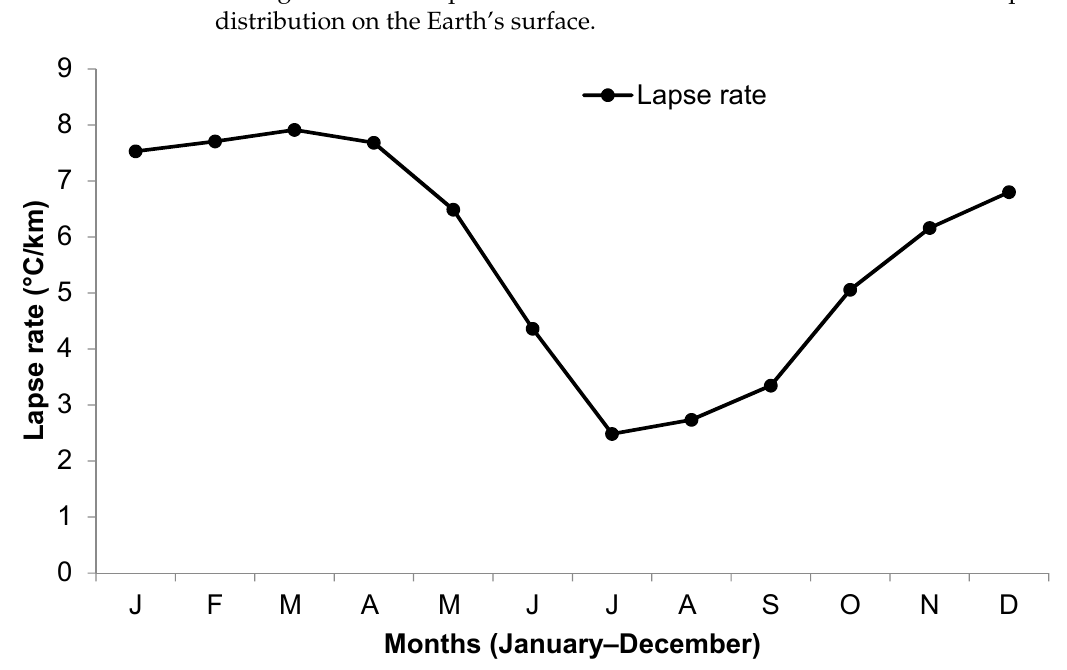
Figure 10. Distribution of the lapse rate values in Uttarakhand for all months in a year for the elevation ranging from 2000 to 6000 m a.s.l.